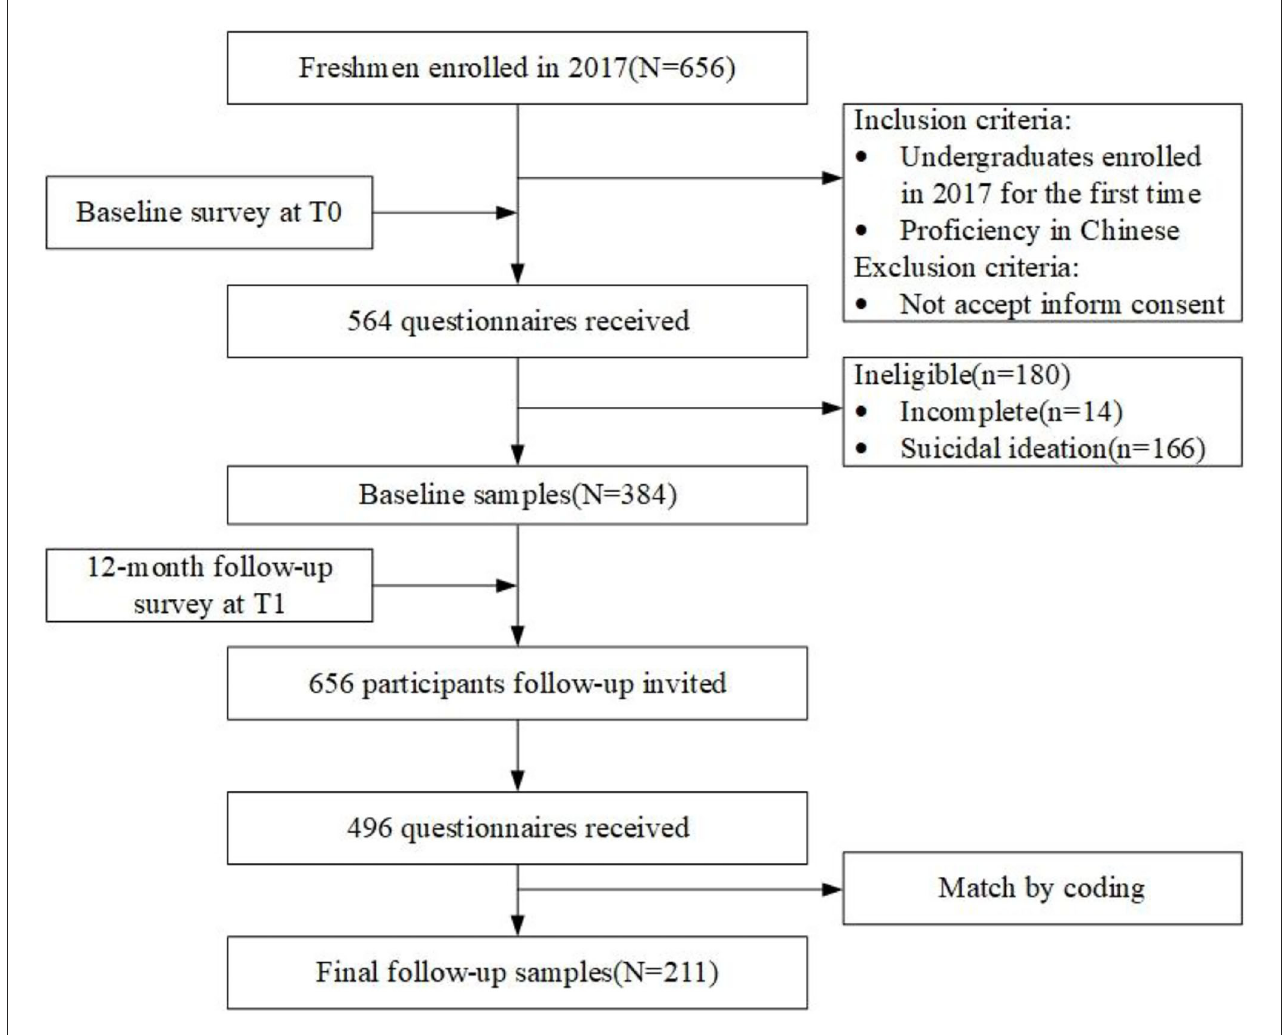
FIGURE1 A flowchart of the study population. T0, baseline survey; T1, follow-up